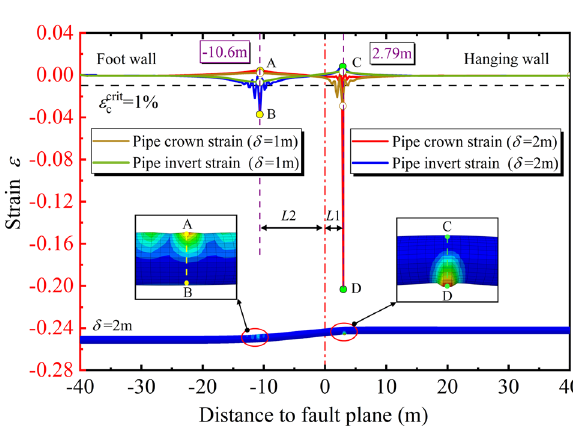
Figure 7. Strain distribution along the pipeline.